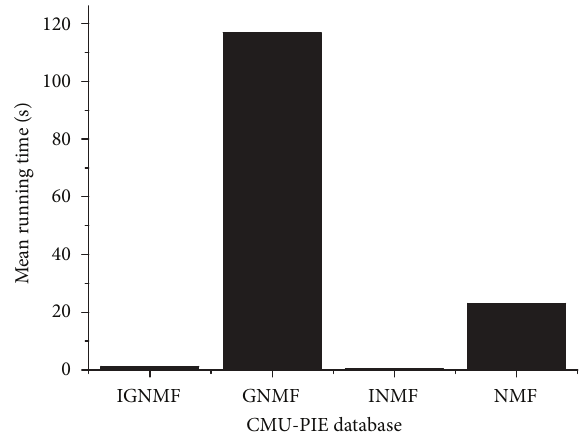
Figure 6: The mean running time during incremental study with single image for the CMU-PIE database.